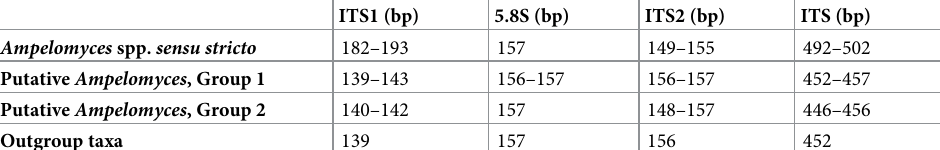
Table 2. Variations in ITS region sequence length can distinguish between Ampelomyces spp. and misidentified